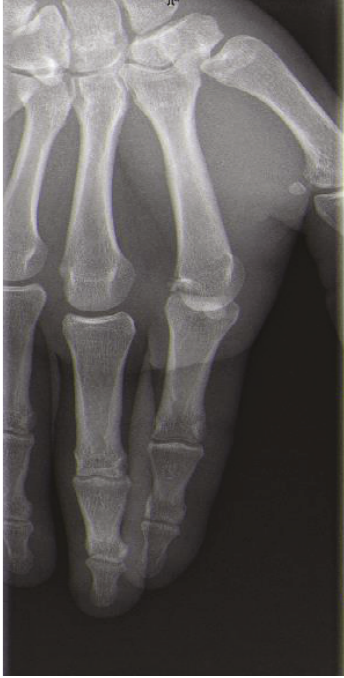
Figure 2: X-Ray (AP view) showing MCP dislocation of the index fi